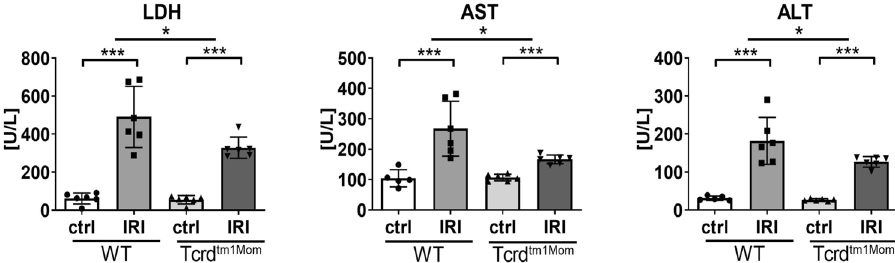
Figure 4. Weaker increase of serum LDH and transaminases following intestinal IRI in γδ T cell deficient mice. Levels of serum transaminases AST (left plot) and ALT (right plot) of wild-type (WT) mice and mice deficient of γδ T cells (Tcrd tm1Mom ) after intestinal ischemia reperfusion (IR) or sham operation (ctrl). Each data point represents data of an individual mouse. Each bar represents group mean; error bar depicts SD. N = 5 6/group. ns not significant. ***p < 0.001. Data are representative of two independent